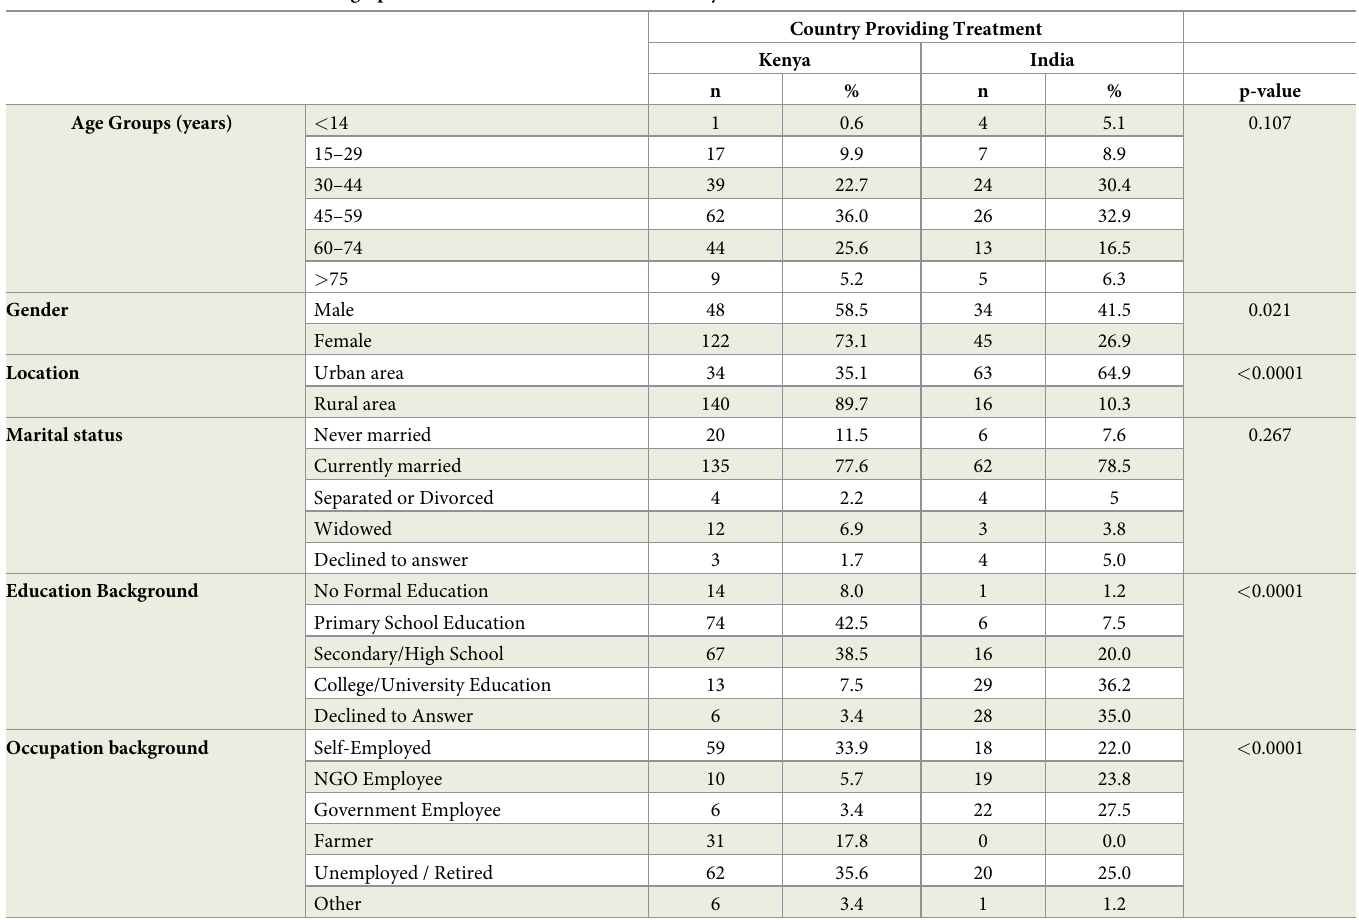
Table 3. Associations between sociodemographic characteristics and choice of